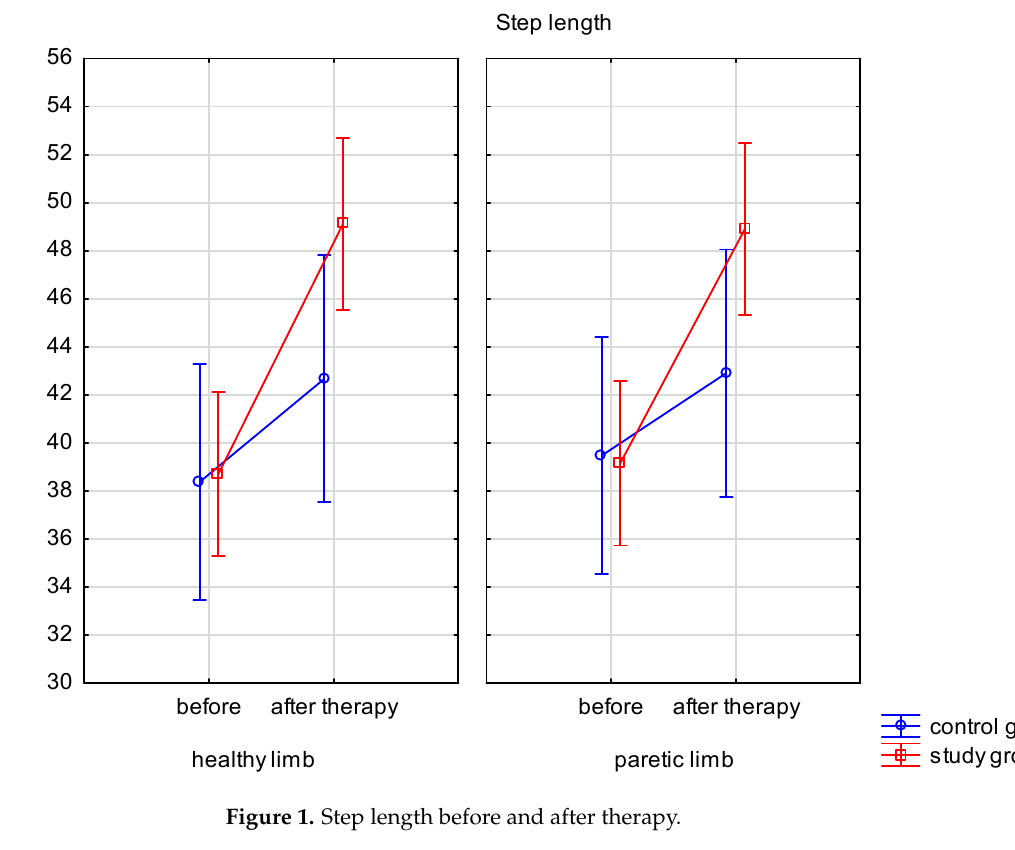
Figure 1. Step length before and after therapy.